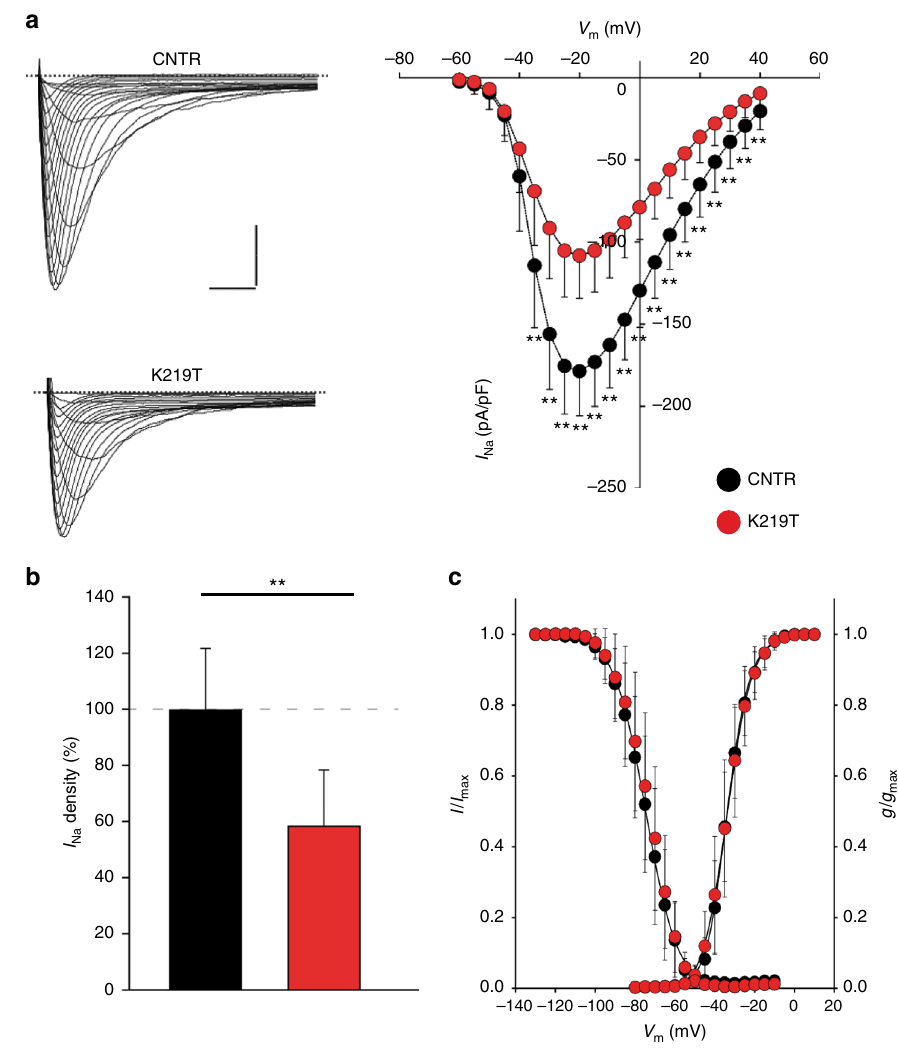
Fig. 2 Voltage-gated sodium currents in CMs from K219T-iPSC lines. a Left panel: examples of Na + current ( I Na ) traces recorded in CNTR- (top) and K219T- (bottom) CMs (Scale bar, 2 ms, 50 pA/pF). Right panel: I-V curves constructed from average peak sodium current density as a function of voltage command measured in CNTR-CMs and K219T-CMs, showing a signi fi cant reduction in the latter. CNTR-CMs: n = 23; K219T-CMs: n = 22. b I Na density, measured at − 30 mV, in K219T-CMs (91.58± 30.69 pA/pF) relative to CNTR-CMs (156.12 ± 33.73 pA/pF), expressed as a percentage. c Voltage dependences: steady state activation (CNTR-CMs: n = 23; K219T-CMs: n = 22)/inactivation curves (CNTR-CMs: n = 18; K219T-CMs: n = 17). All values are reported as mean ± SD. ** p < 0.005 (unpaired t -test). Data are relative to CMs differentiated from 2 independent lines from 2 CNTR and 3